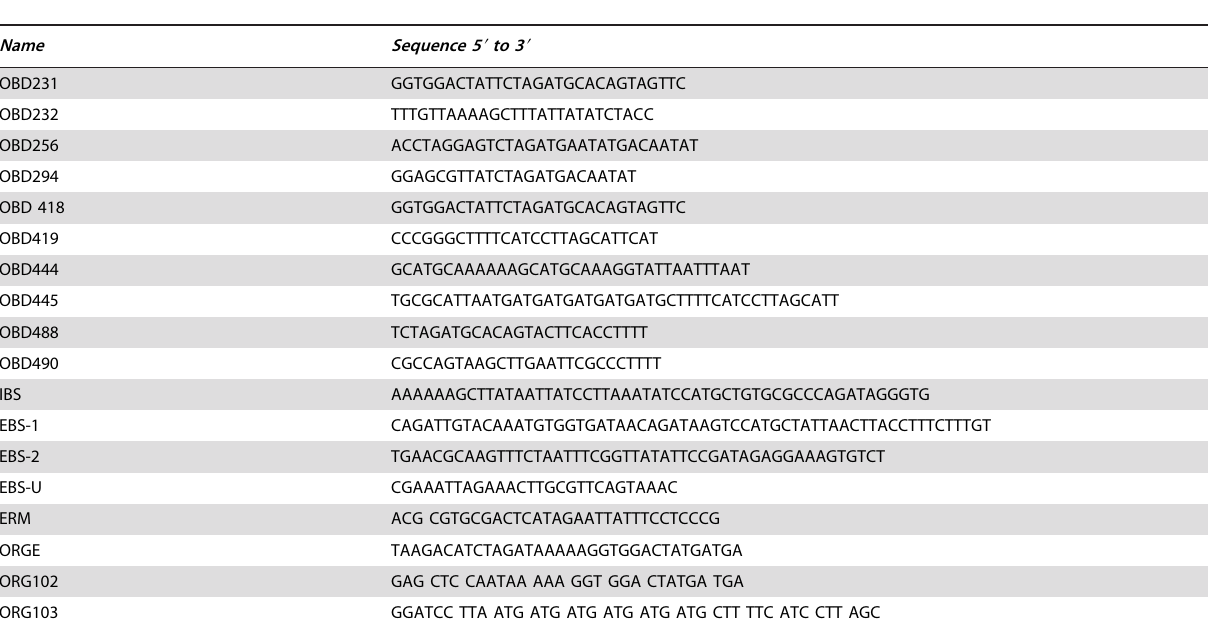
Table 2. Oligonucleotides used in this